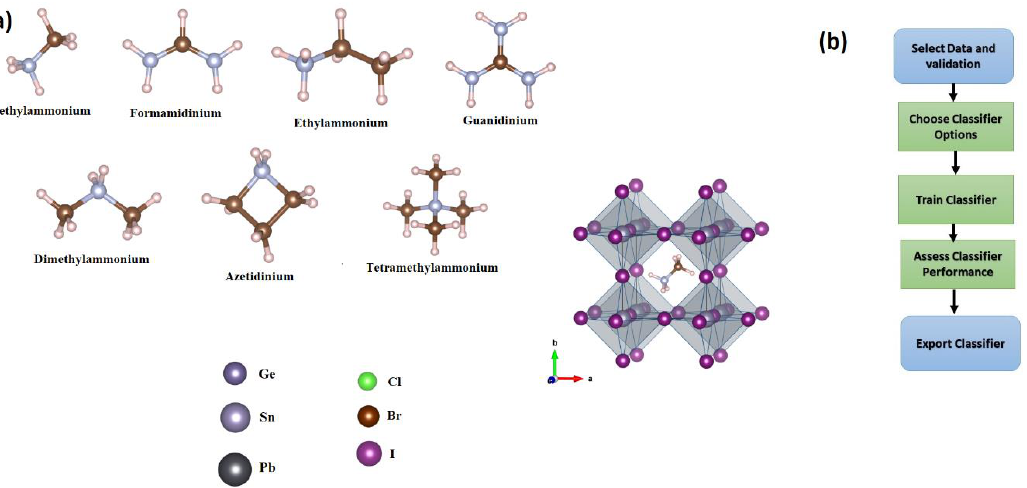
Figure 1. ( a ) Schematic representation of ABX 3 with different molecules, metals, and halide atoms. Carbon, nitrogen, and hydrogen atoms are illustrated in dark brown, gray, and light pink, respec- tively. ( b ) Flow chart of a typical procedure for training classification models, or classifiers, in the Classification Learner program.